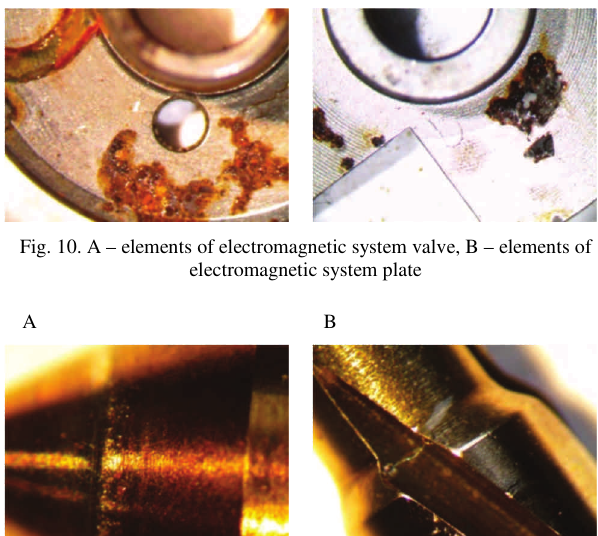
Fig. 7. A – not working part of the injector piston, B – precision element of the injector piston Fig. 11. A – corroded fuel injector needle, B – fuel intake channels dam- aged by cavitation corrosion in Delphi